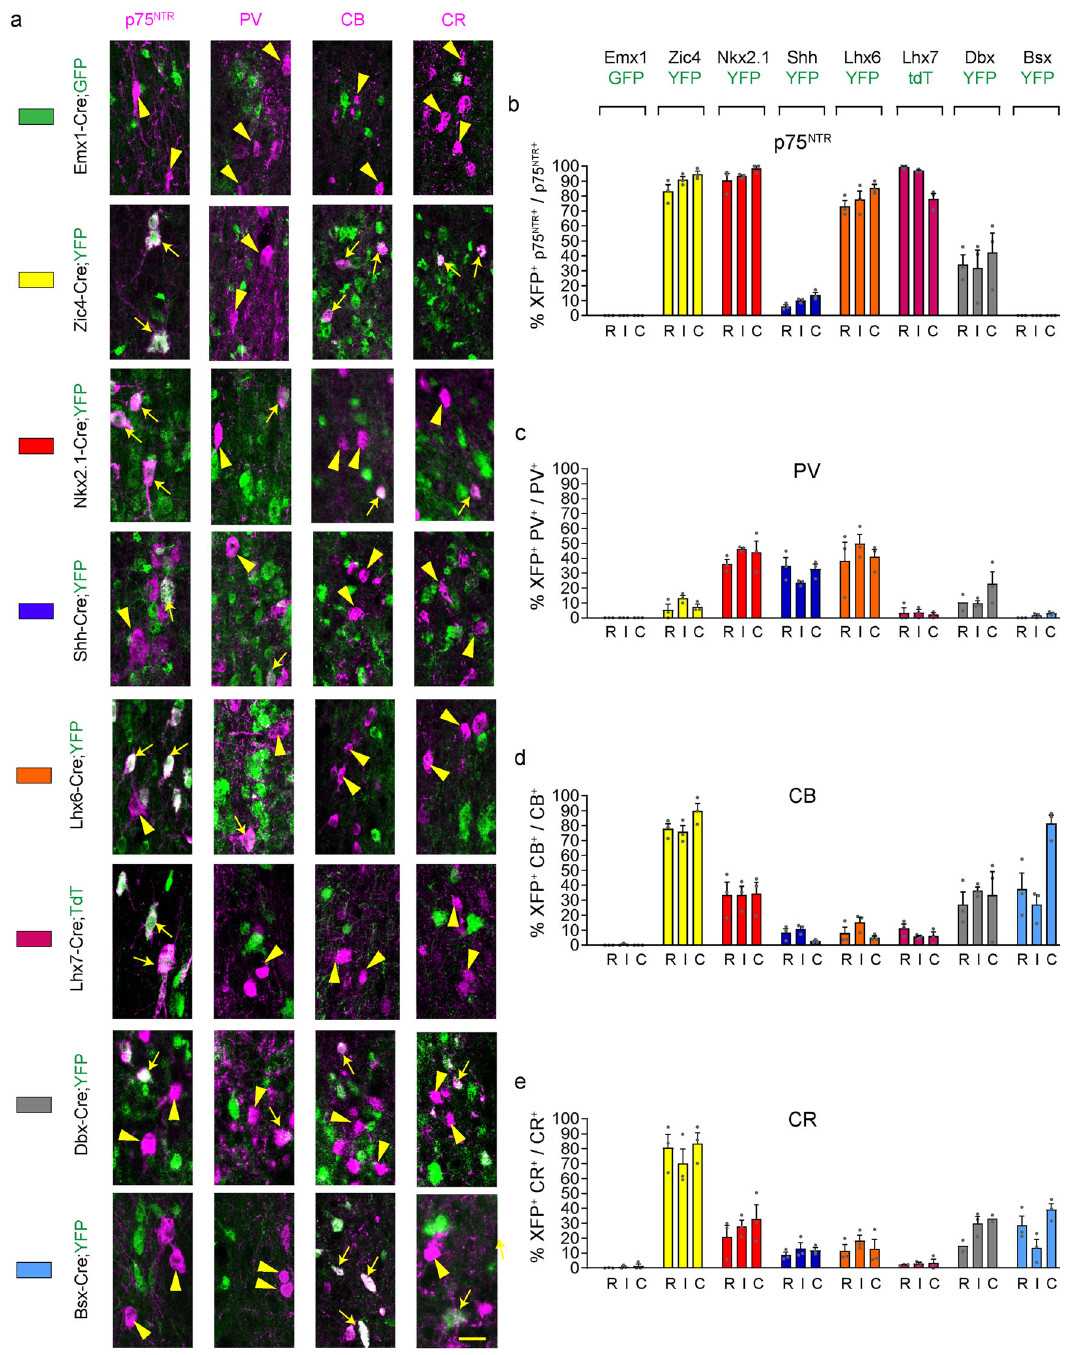
Fig. 4 Septal and extra-septal embryonic origins of medial septal neurons. a Contribution of different forebrain domains to MS populations. Double- labelling for p75 NTR , CB, CR or PV and the fl uorescent reporter protein GFP/YFP/TdT in the various transgenic lines at P30. White arrows and arrowheads indicate double and single labelled cells, respectively. b – e Histograms showing the percentage of neurons double labelled for GFP/YFP/TdT over the total population. Each transgenic line is identi fi ed by a different colour as shown in a and as summarised in Fig. 2d, e. n = 3 brains per transgenic line per marker except the following where n = 2 for Dbx-Cre;YFP mice: PV R, CR R and C. Histograms show Mean + SEM. Source data are provided in Supplementary Data 1. Scale bar: 25 μ